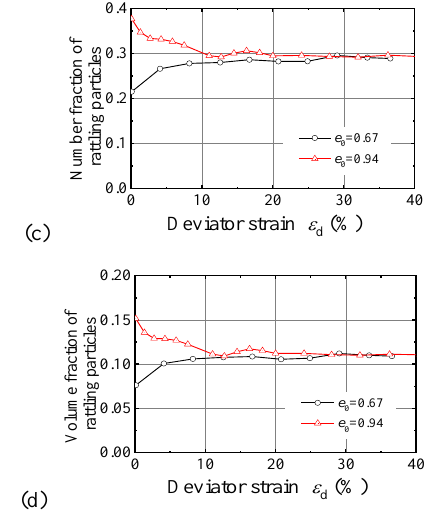
Fig. 2. Effects of sample density on mechanical responses of clean sand (PSD2): (a) stress ratio, (b) conventional and effective void ratios, (c) number fraction of rattling particles, and (d) volume fraction of rattling particles.